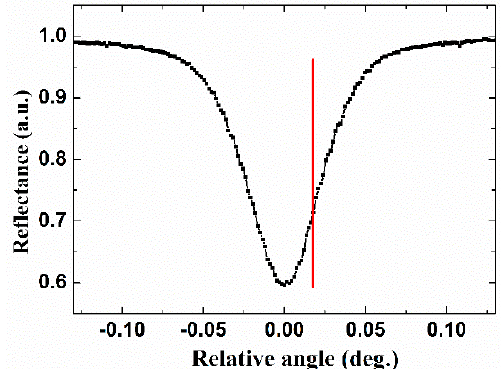
Figure 5. The measured reflected intensity with the BSW excitation for water cladding. (red solid line: the working angle).